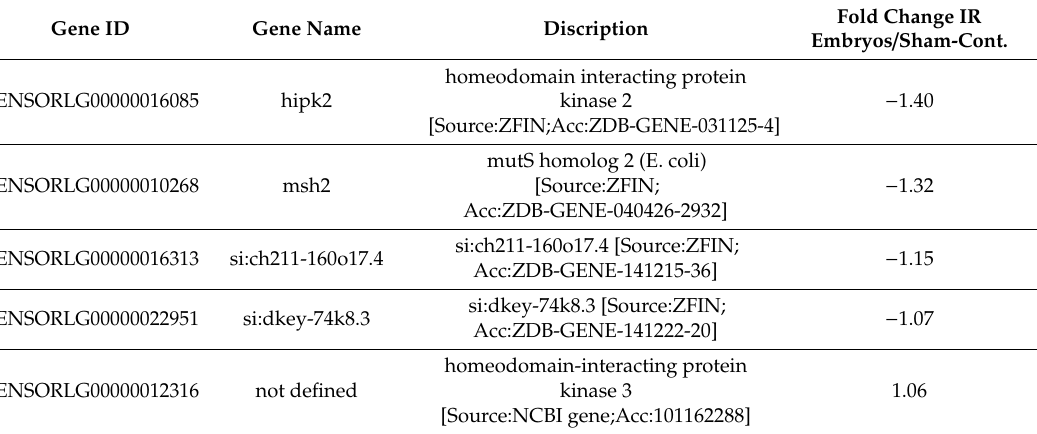
Table 1. Intrinsic apoptotic signaling pathway in response to DNA damage by p53 mediator.